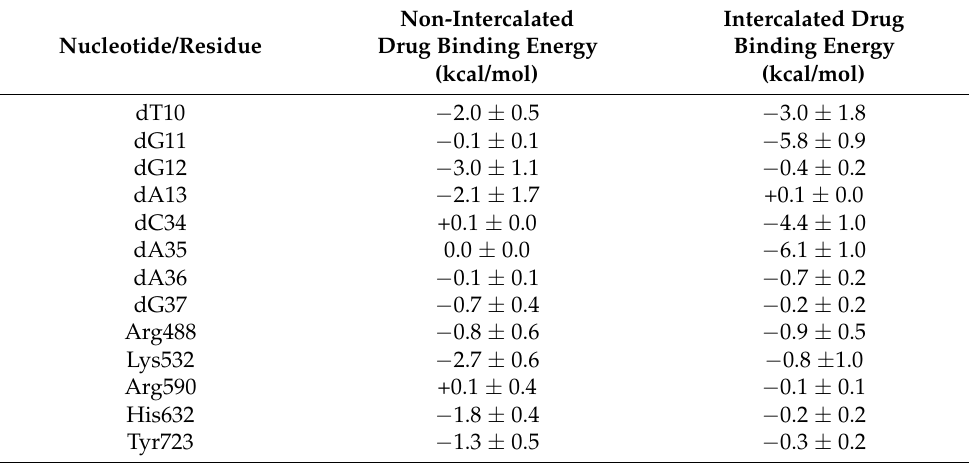
Table 2. MM/GBSA per-nucleotide/residue decomposition analyses performed for the MD trajecto- ries of the htopIB-DNA complexes bound to the drug in non-intercalated (Figure 5A) and intercalated (Figure 5C) configurations. Interaction energies were evaluated between the drug and surrounding DNA bases or htopIB active site